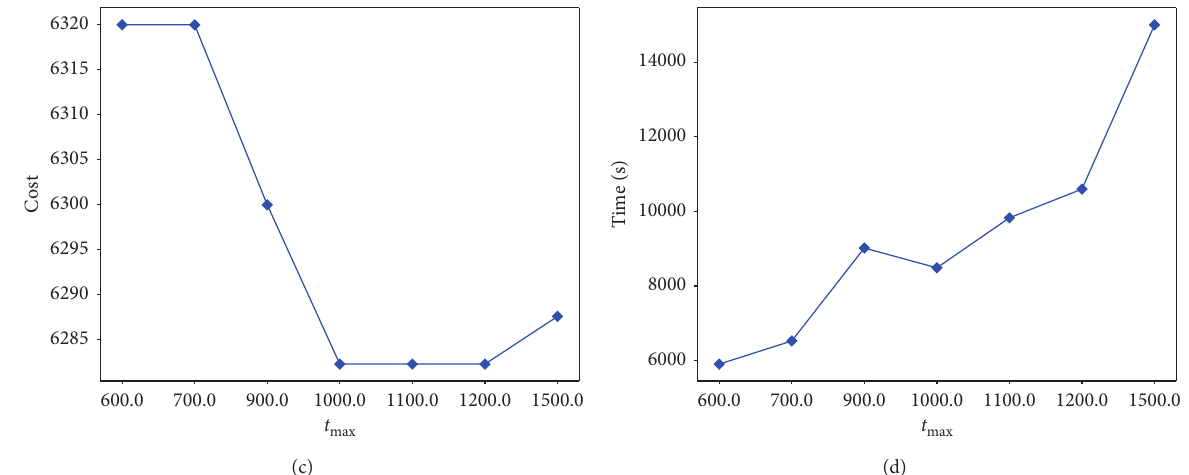
Figure 3: Sensitivity with respect to T . (d) Solving time vs. t Cost vs. t max